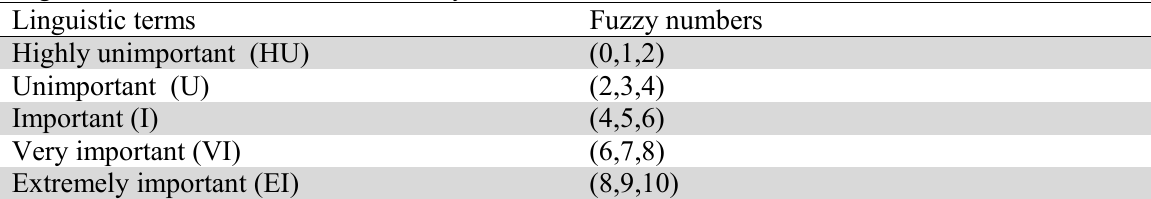
Linguistic terms and the associated fuzzy numbers